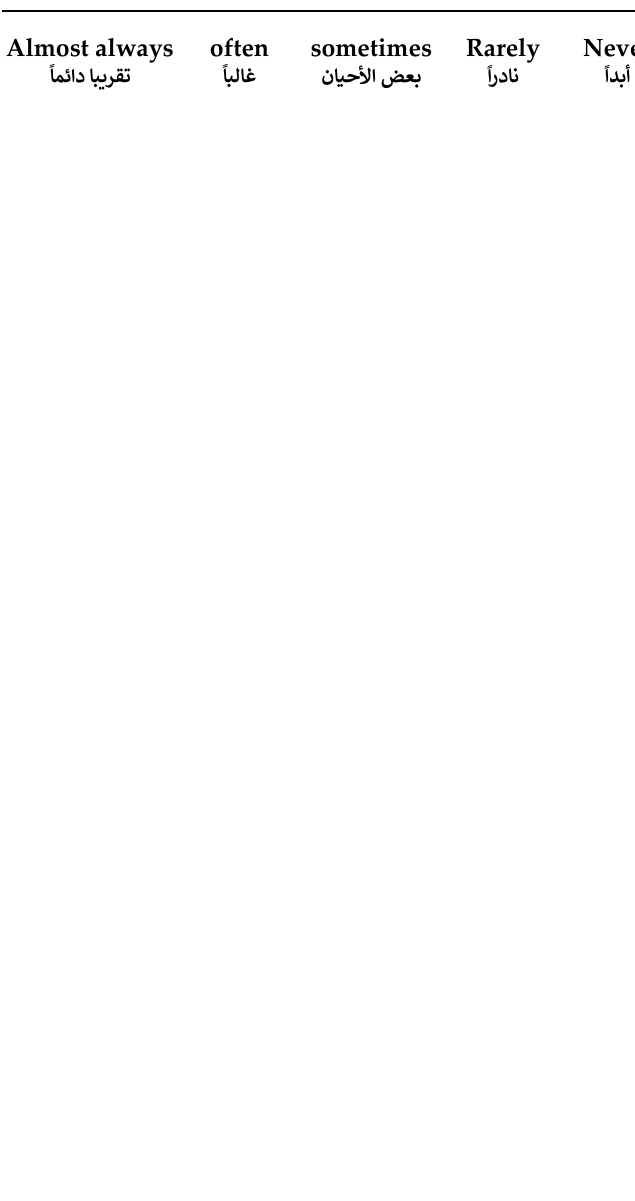
Table A2. Translated items of the Perseverative Thinking Questionnaire in Arabic language.